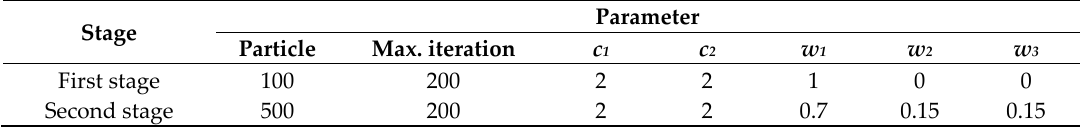
Table 1. Parameters of particle swarm optimization (PSO) of IEEE 37-bus test system.